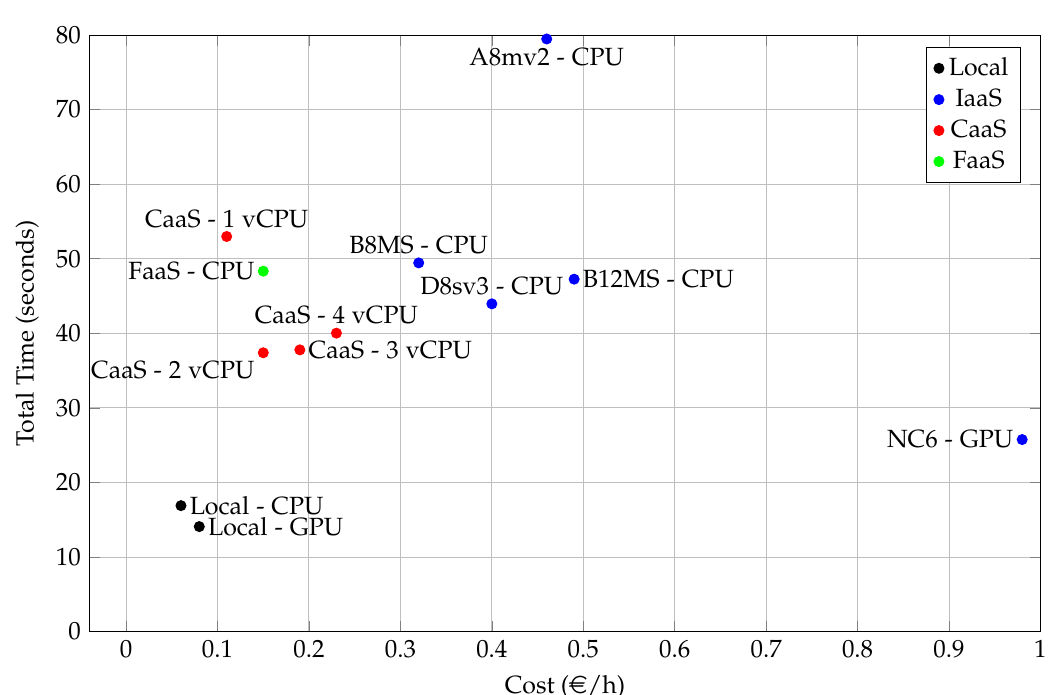
Figure 10. Performance vs. cost comparison using a batch of 100images of 416 × 416 pixels. The NC12 infrastructure is not included in this chart because it performs worse than NC6 at a higher cost. NC6-CPU is not included either as in a real case it does not make sense to pay for a GPU and not use